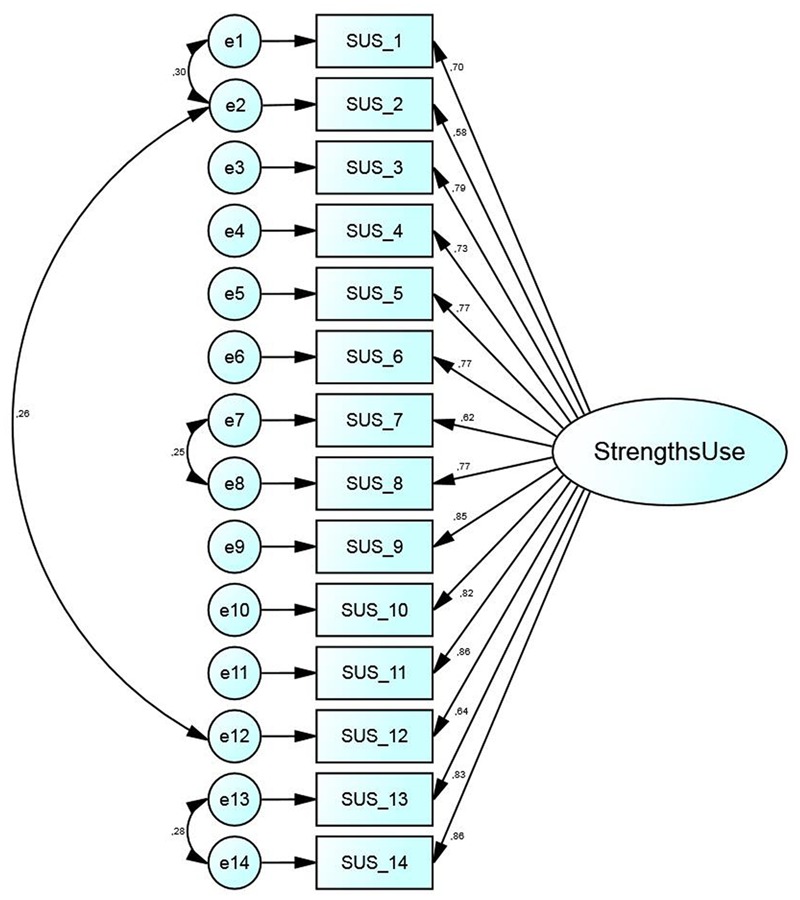
Factorial structure of the German SUS.